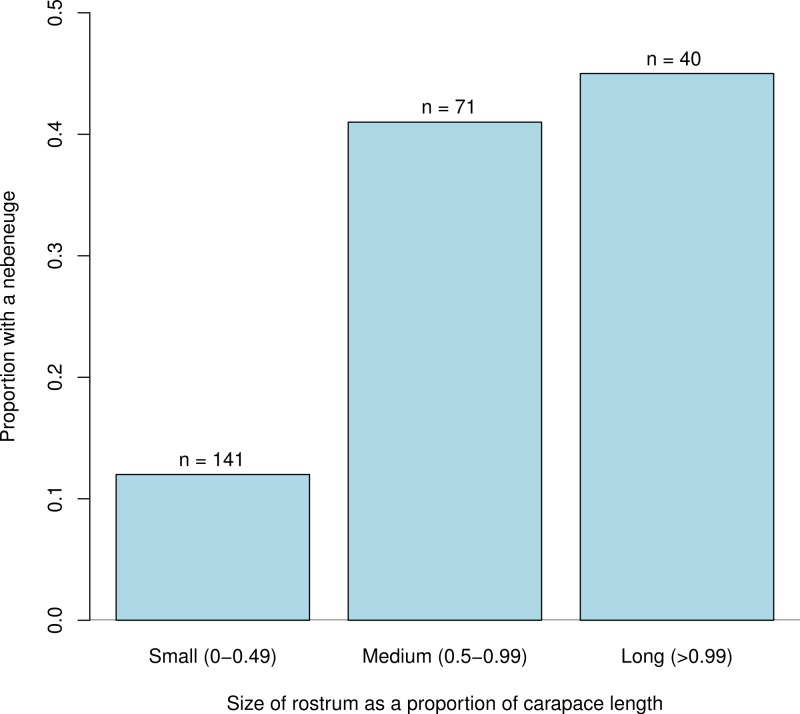
Nebenaugen proportions.Proportion of caridean decapods that have a nebenauge in relation to the relative length of their rostra. Rostrum size is relative to the carapace length.